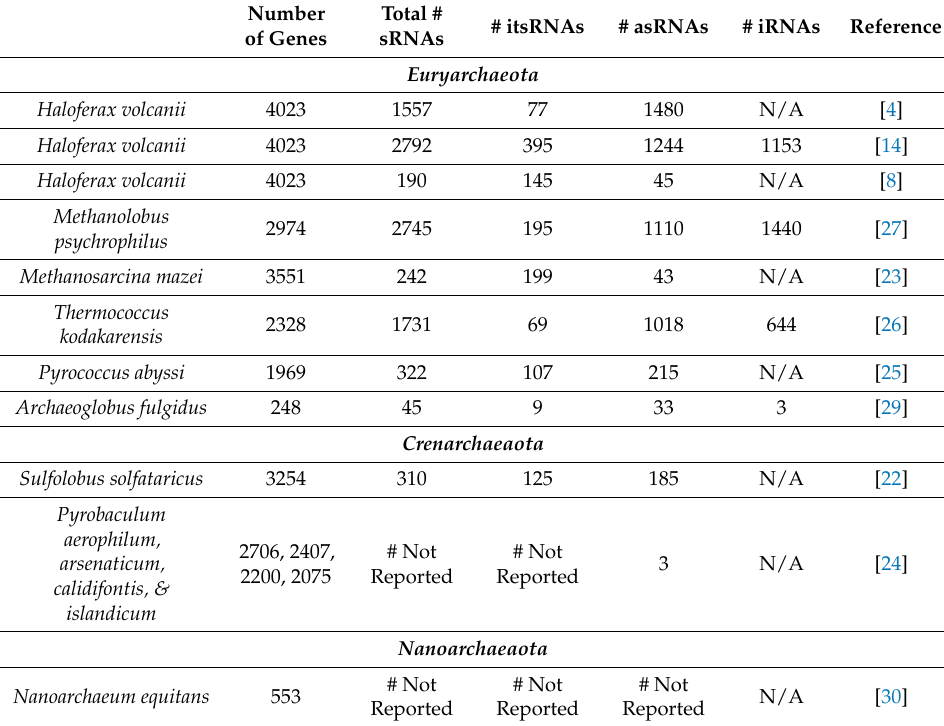
Table 1. Summary of small non-coding RNAs (sRNA or ncRNA) discovered in the Archaea. Number of Genes